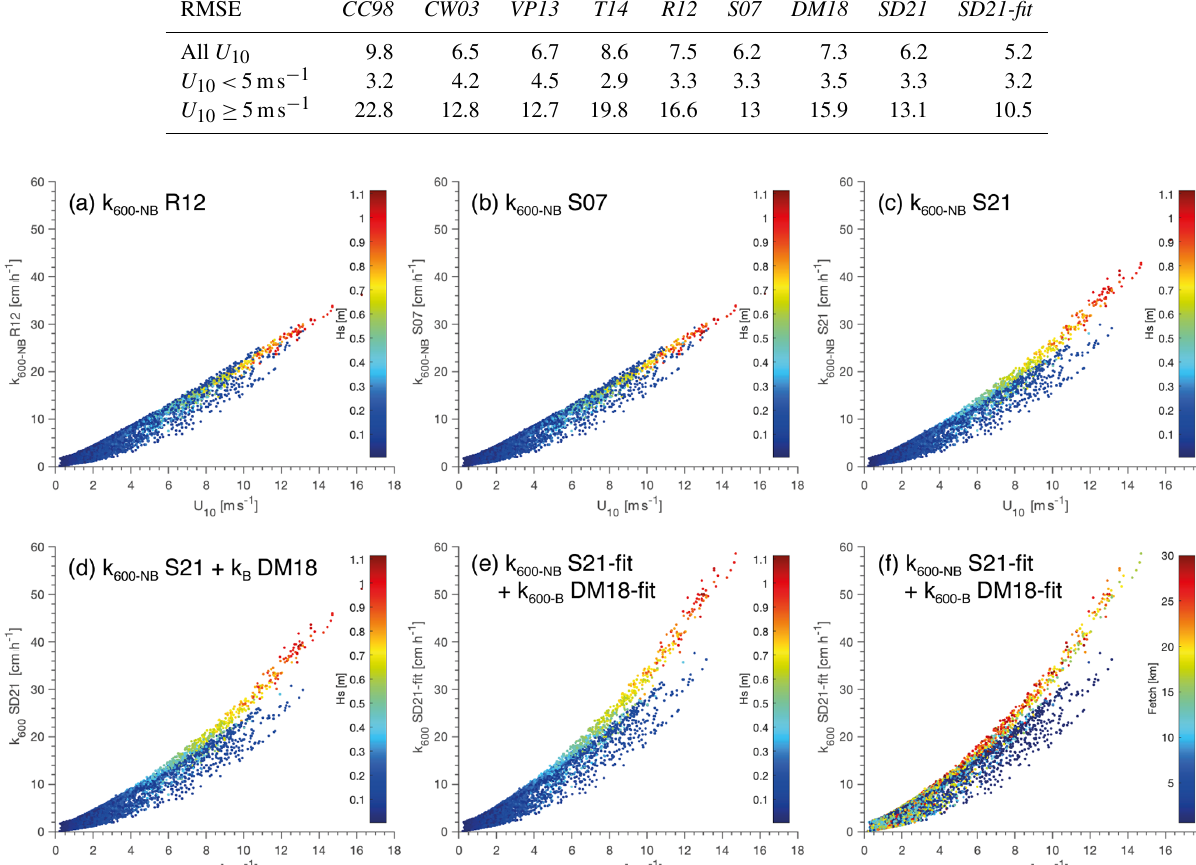
Figure 5. The U 10 vs. k 600 relationship modelled and coloured according to H s (colour bar) in panels (a) – (e) as well as coloured according to fetch distance (colour bar) in panel (f) : (a) R12 integrating wind shear and convection; (b) S07 integrating wind shear, convection, and wave action for fully developed waves; (c) S21 integrating wind shear, convection, and wave action for waves that are not fully developed; (d) SD21 is similar to S21 but the k -bubble term of DM18 is added; (e,f) SD21-fit is similar to SD21 but with a 1 and A B fitted to observed k